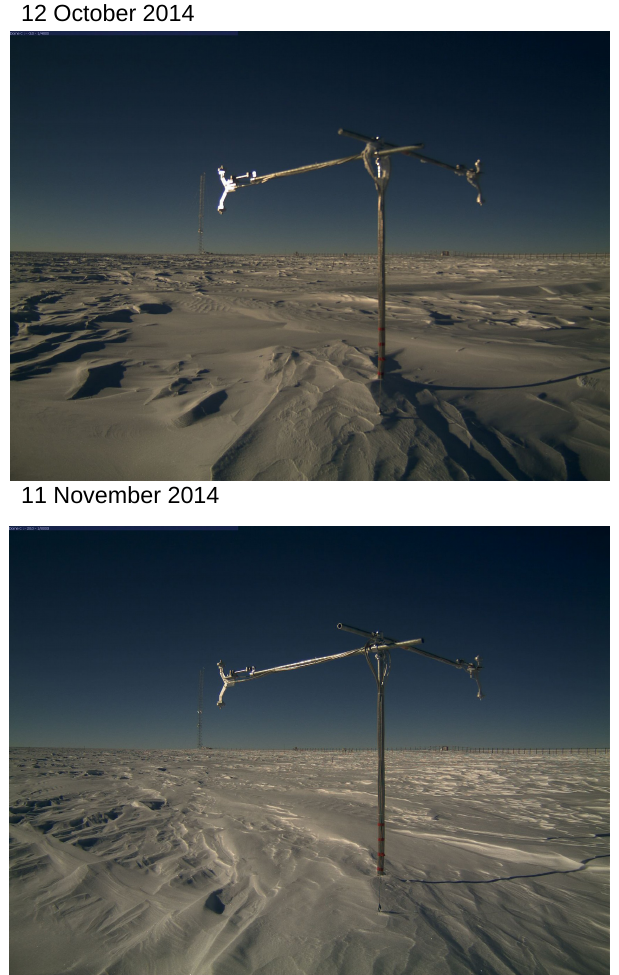
Figure 5. Pictures of the snow surface under Autosolexs head (head 1 is on the left) on 12 October and 11 November